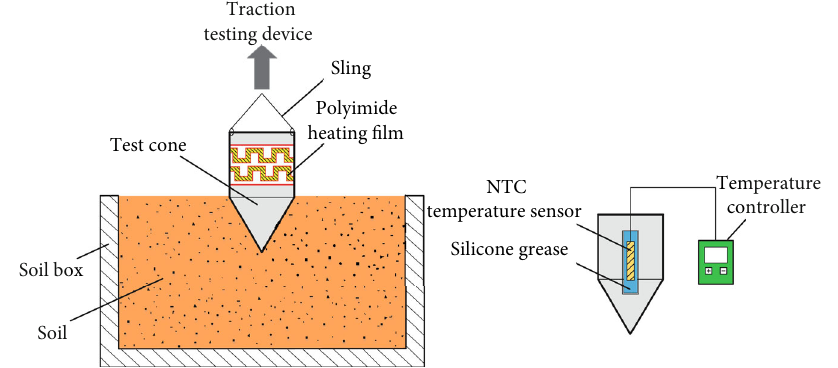
Figure 2: Adhesive test equipment of interface temperature.